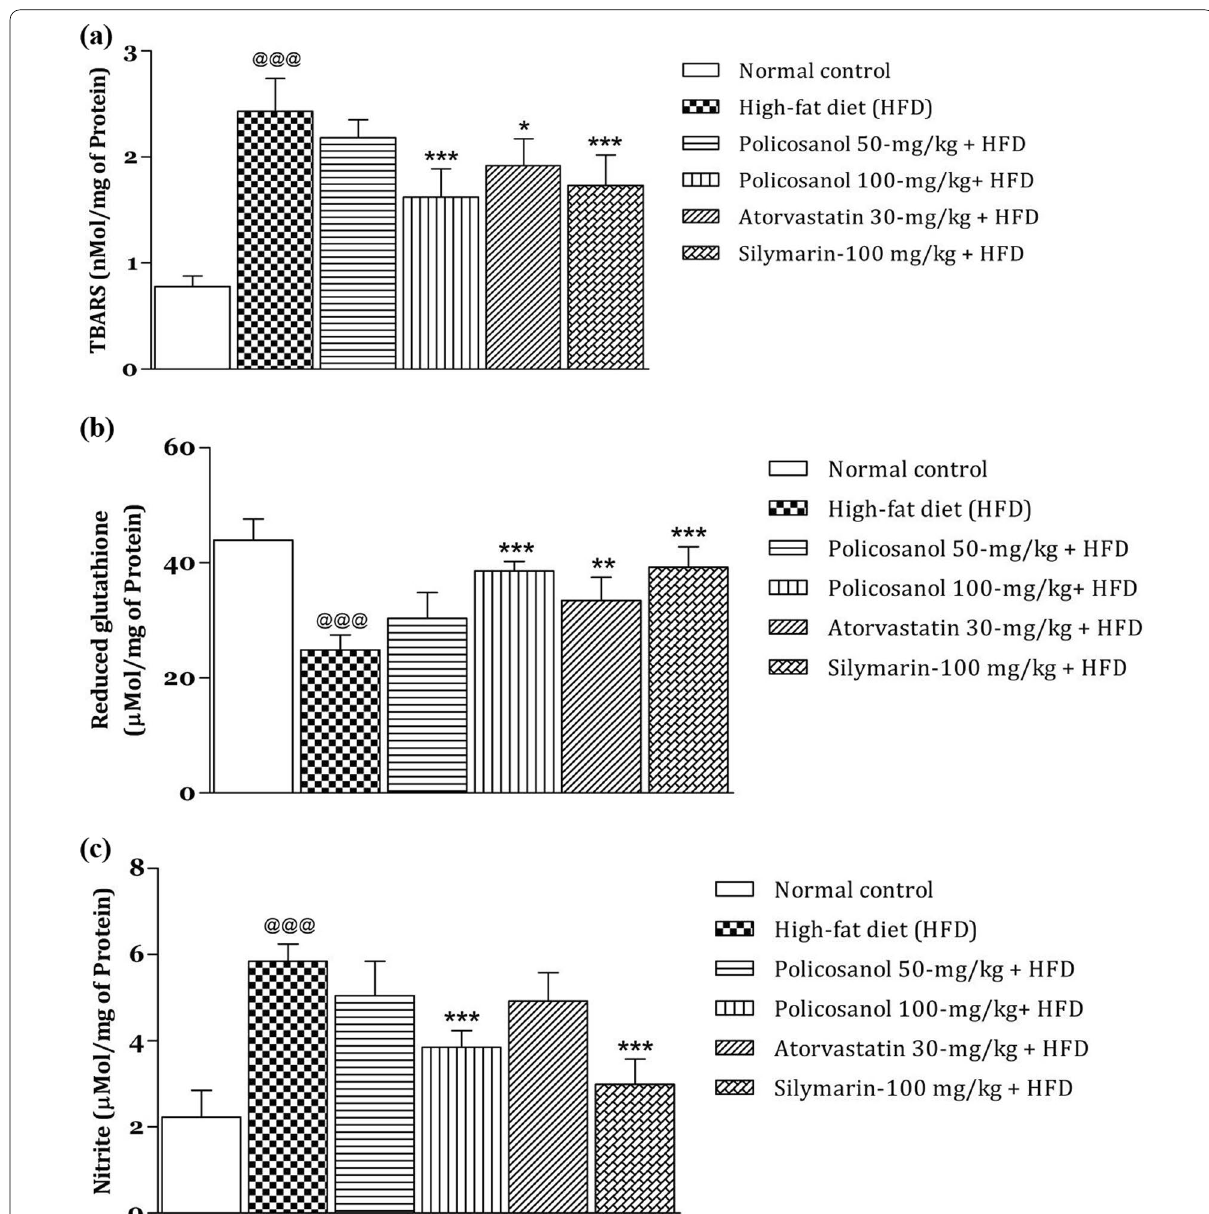
Fig. 2 Effect of policosanol, atorvastatin, and silymarin treatments on oxido-nitrosative parameters: a TBARS, b reduced glutathione, c nitrite level in HFD-fed animals. All values are represented as mean *** p < 0.001 as compared with HFD